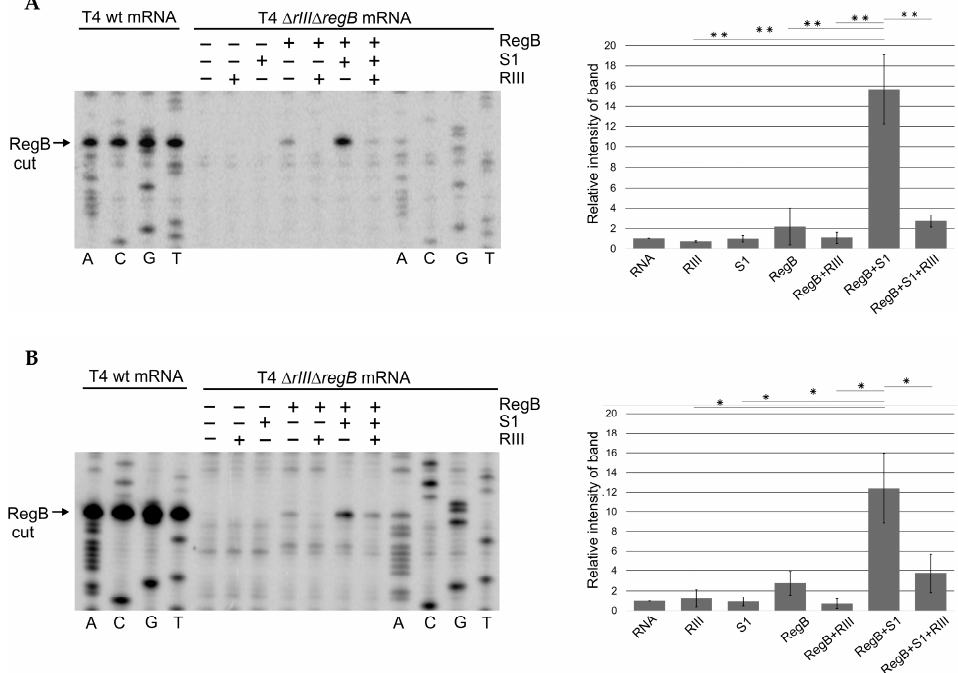
Figure 4. Primer extension analysis of T4 early mRNAs in vitro exposed to the diverse sets of recombinant proteins. ( A ) The representative image and analysis of RegB cleavage using 5 ′ - 32 P-labeled primer No. 35 complementary to the gene motA mRNA. ( B ) The representative image and analysis of RegB cleavage using 5 ′ - 32 P-labeled primer No. 36 complementary to the gene 30.7 mRNA. Total RNA was isolated from the E. coli cells 2 min post-infection with either phage T4 wt or T4 ∆ rIII ∆ regB at 37 °C. The 20 μ g aliquots of RNA were subjected to either Sanger dideoxy sequencing or primer extension analysis. The latter analysis was performed after exposure of RNA to different sets of the His-tagged recombinant proteins specified at the top of the lines. The quantity of RegB-cleaved mRNAs was analyzed using GelAnalyzer and Microsoft Excel as described in the Methods section. All values are means ± SD from three independent experiments (Figure S4) (* p < 0.03, ** p < 0.02, Welch’s t -test).